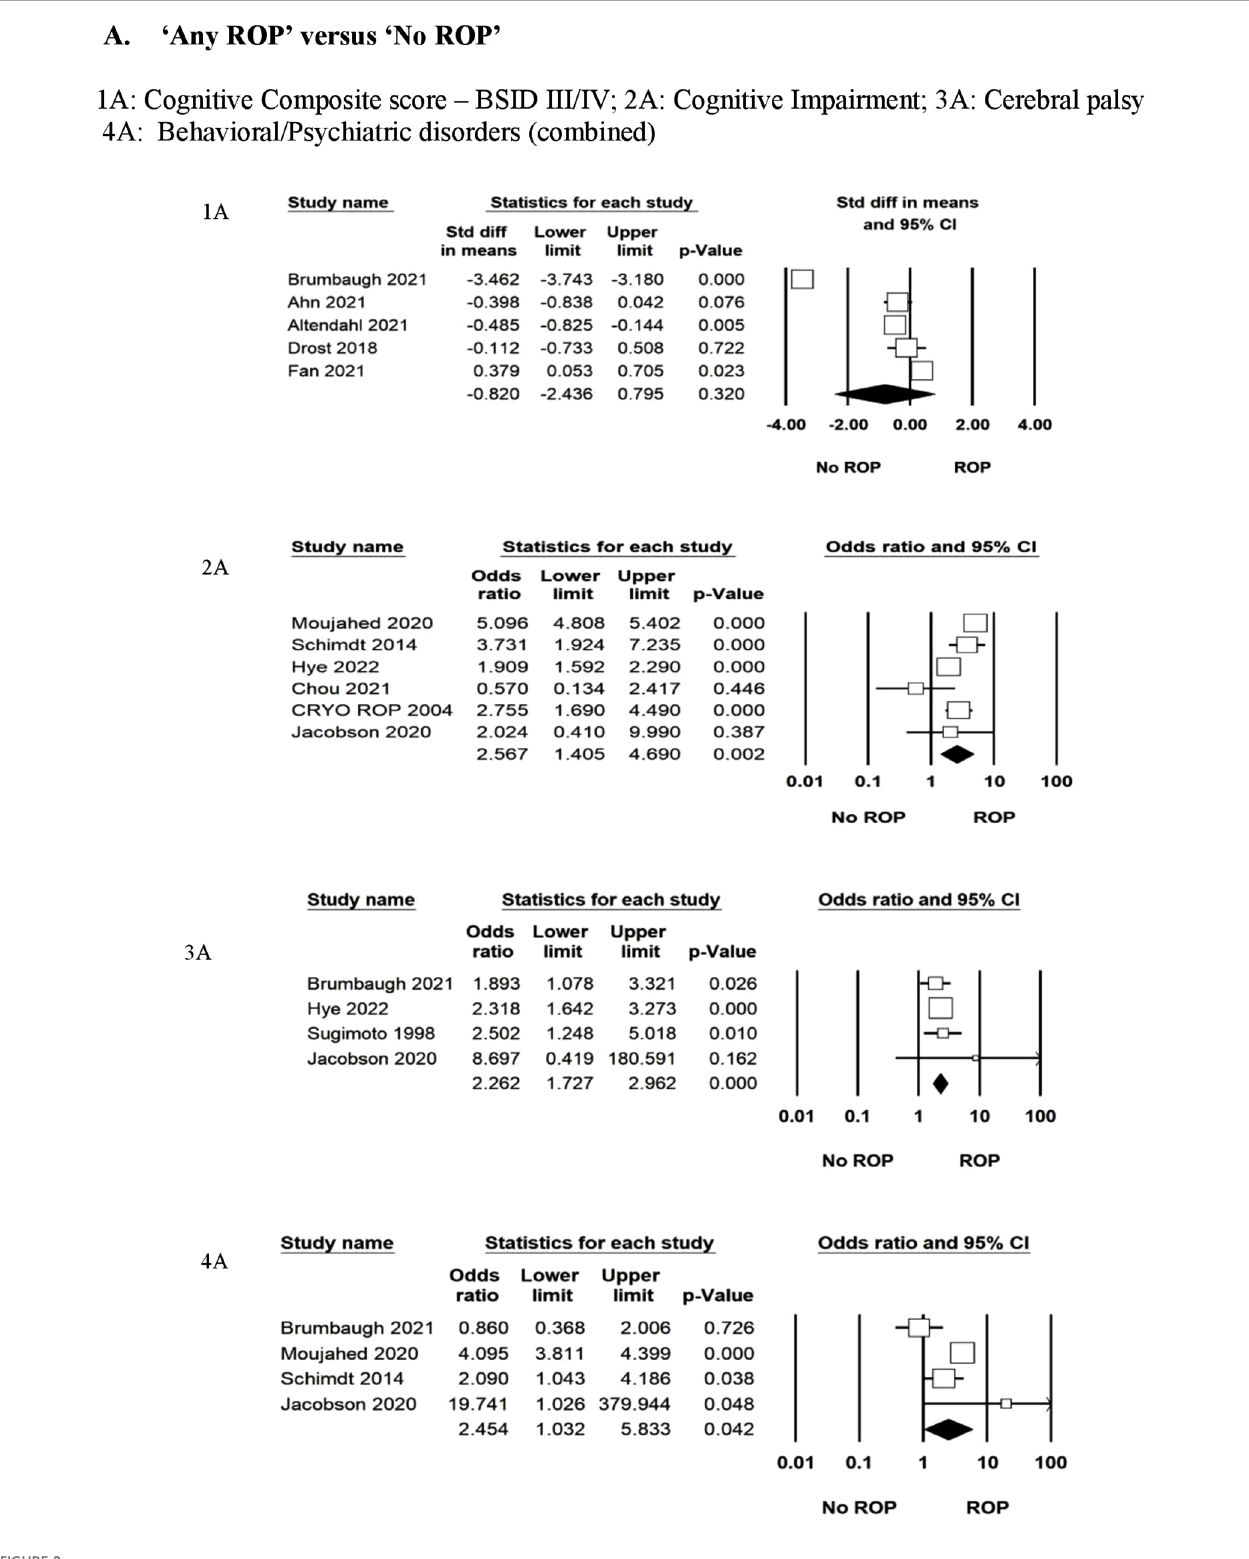
FIGURE 2 Forest plots for primary and important secondary long term neurodevelopmental